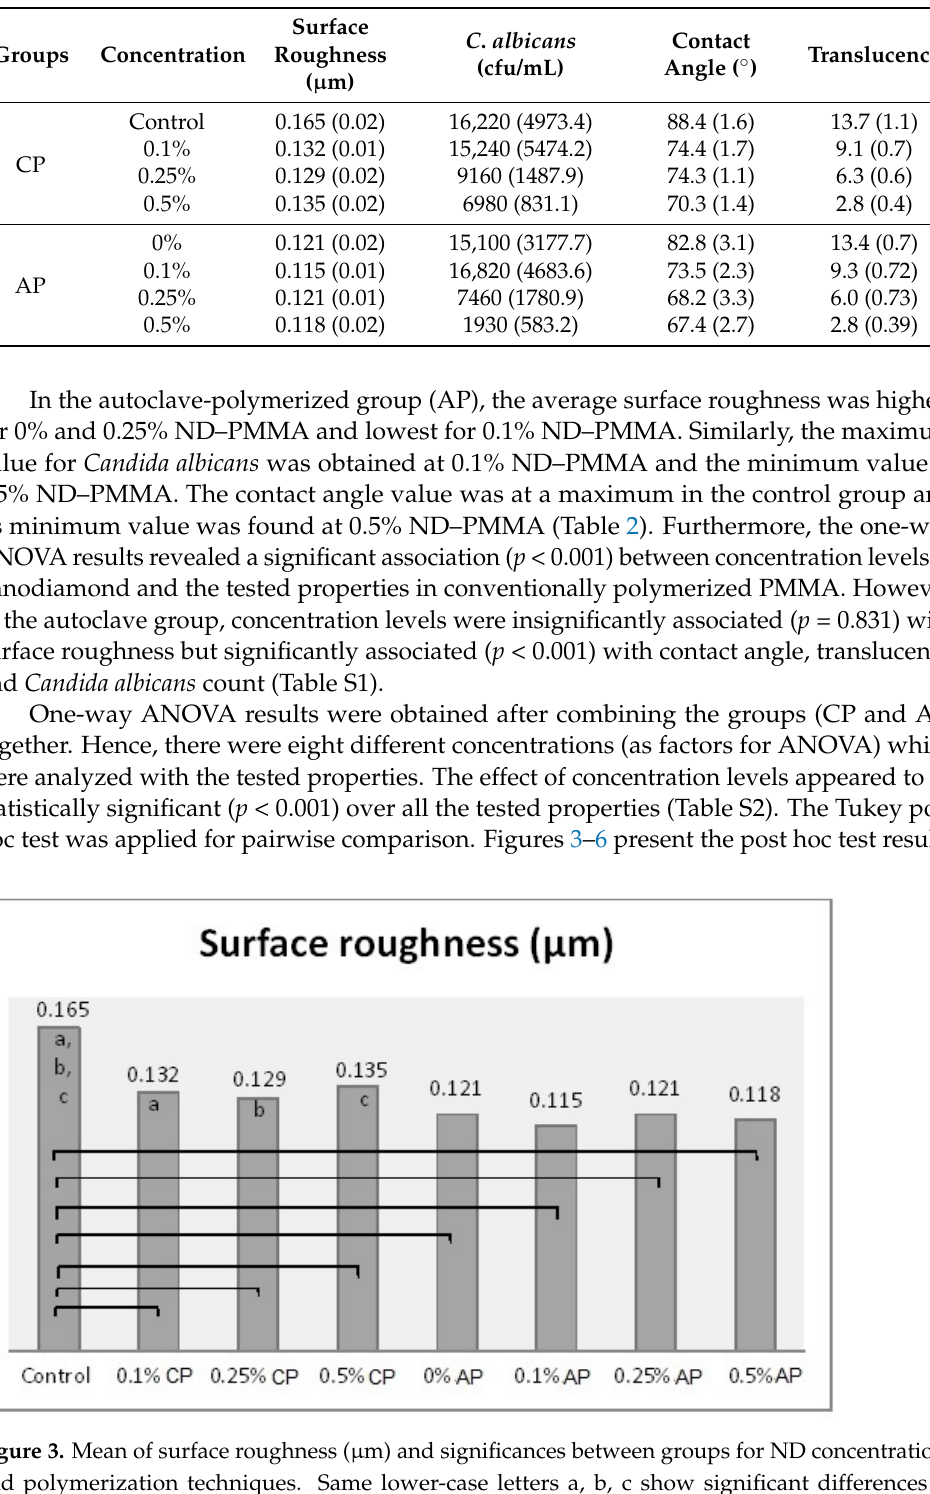
Table 2. Average and standard deviation values of tested properties.